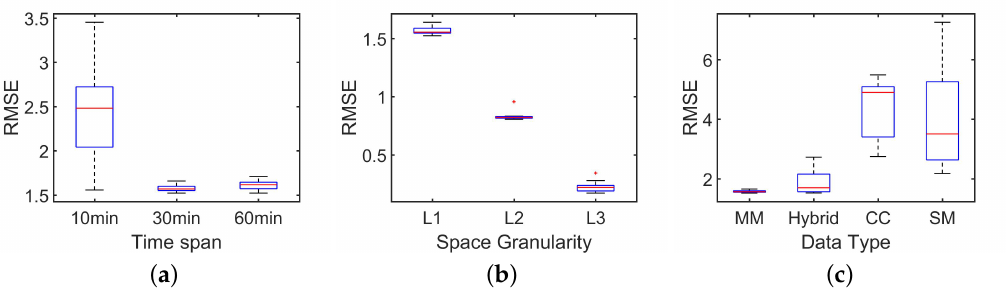
Figure 9. Accuracy evaluation based on RMSE. ( a ) RMSE with different time slot; ( b ) RMSE at different space granularity: L1 (the smallest space unit), L2, L3 (administrate units); ( c ) RMSE with different data: MM (mobility management data), CC (call records), SM (short message